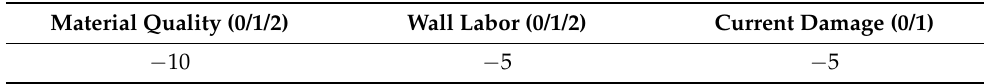
Table 9. Current status and quality negativity scores [16].